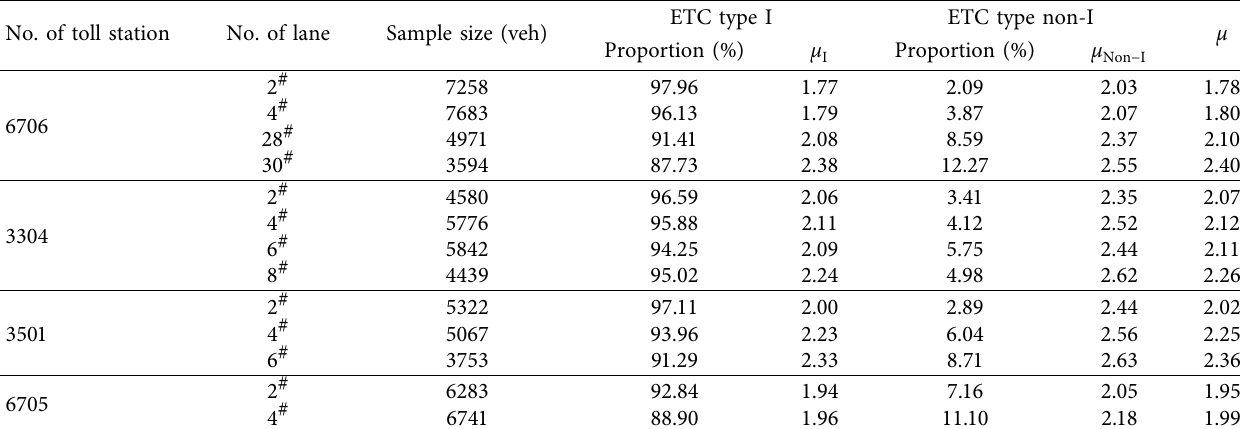
Table 4: Fitting parameters for the lognormal distribution of service time when ETC exits of toll stations are saturated. No. of toll